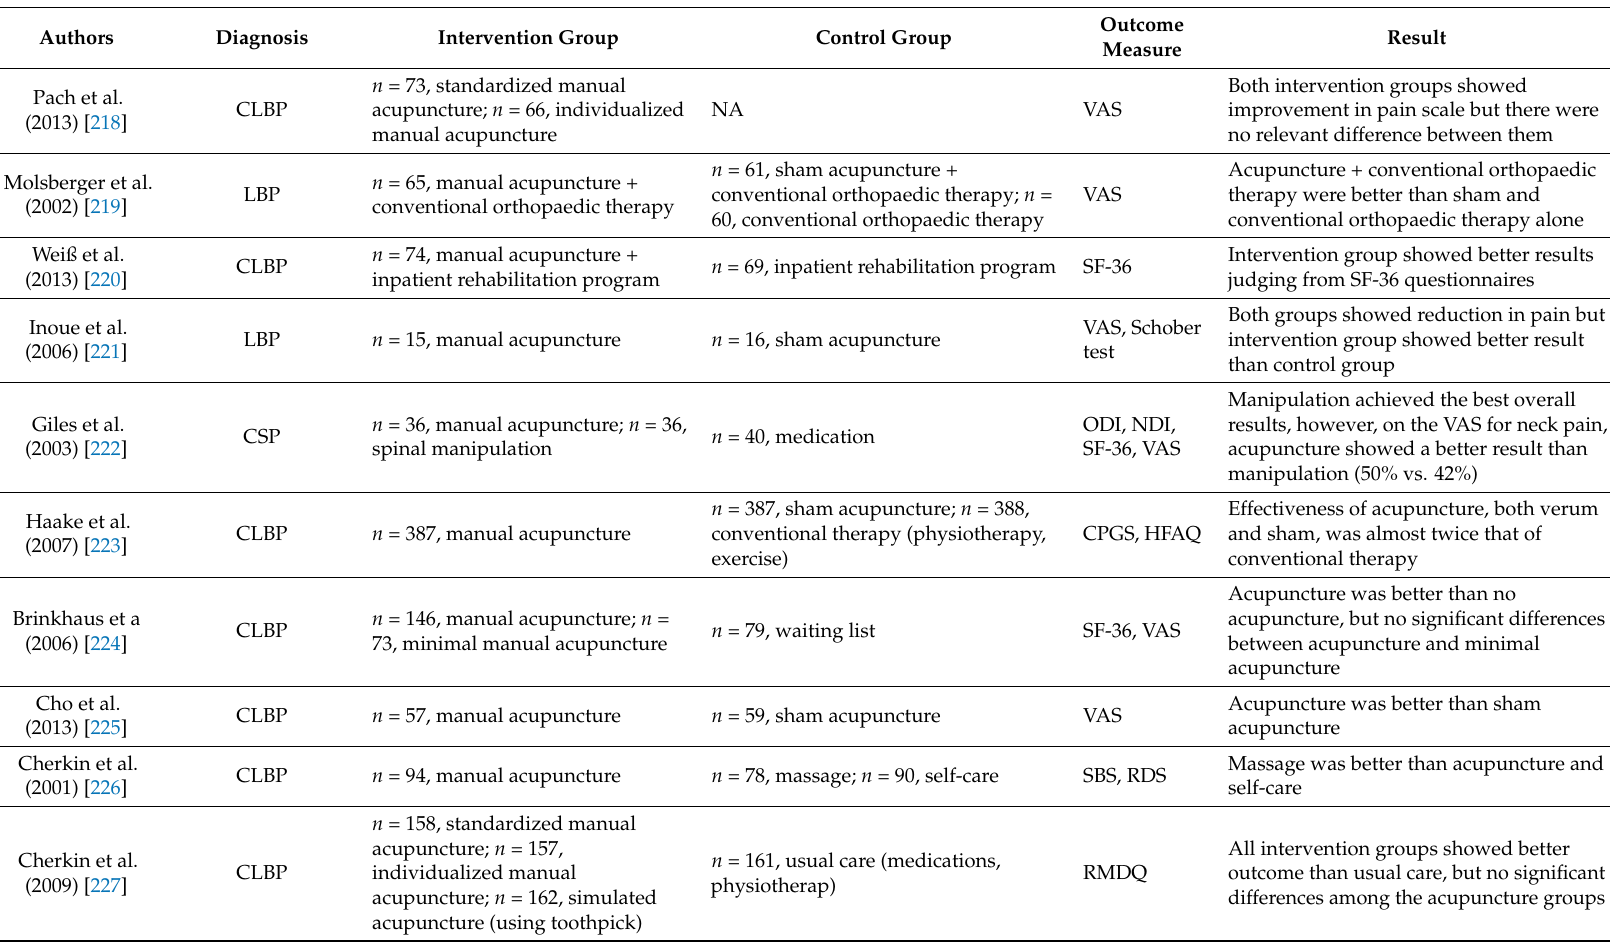
Table 1. Results of randomized control trials for acupuncture treatment of lower back